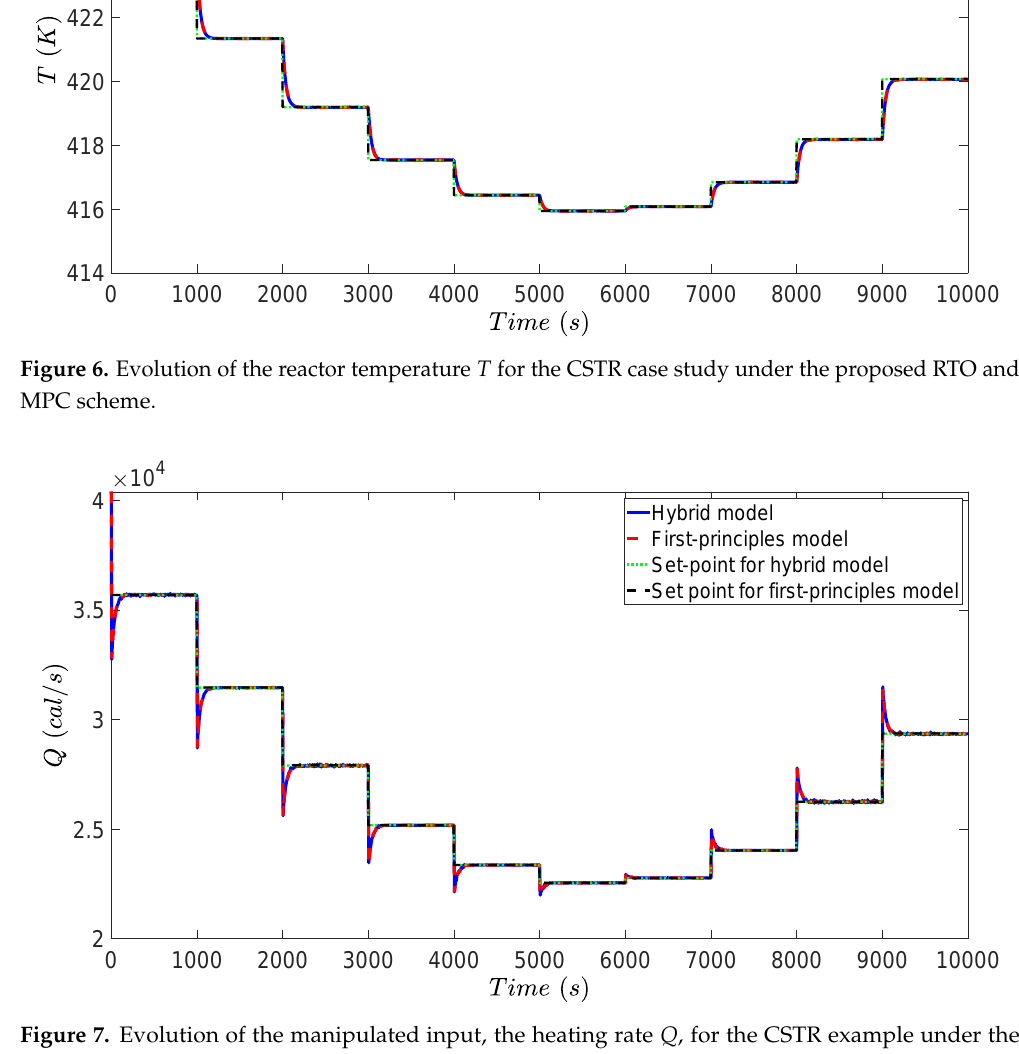
Figure 7. Evolution of the manipulated input, the heating rate Q , for the CSTR example under the proposed RTO and MPC